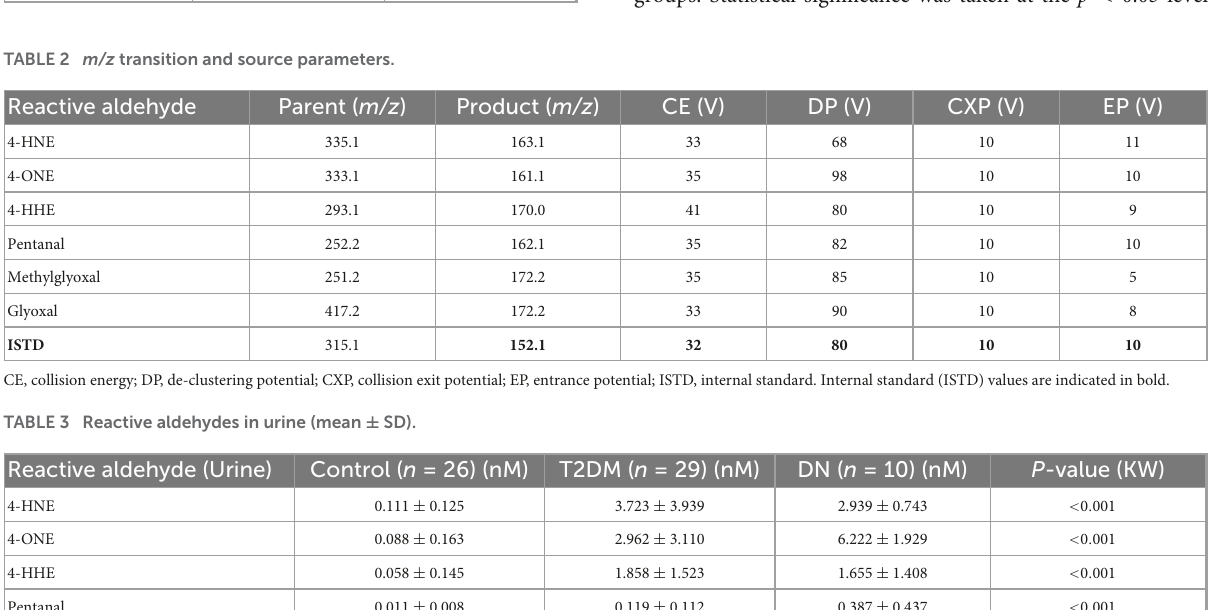
TABLE 2 m/z transition and source parameters. Reactive aldehyde